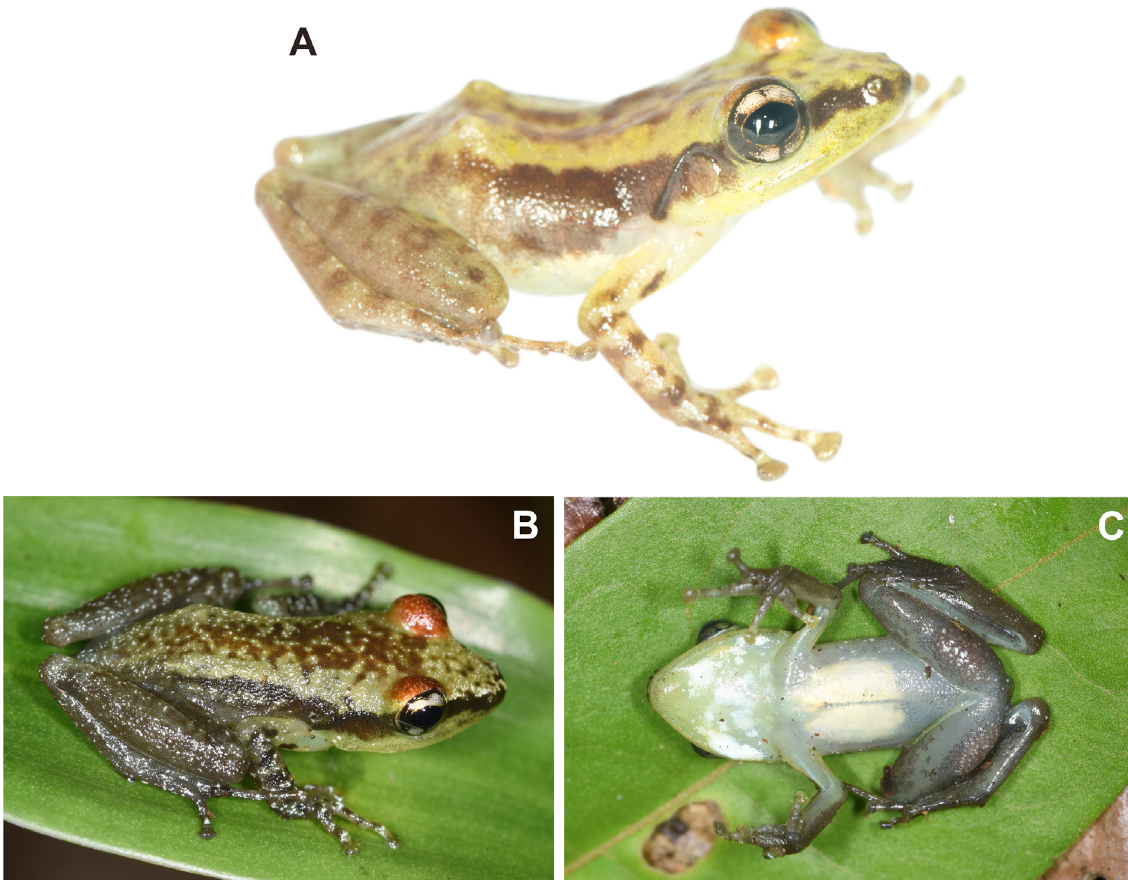
Fig. 5. Guibemantis woosteri sp. nov. in life. A . zSM 425/2016 (zCMV 15185) from Marojejy. B–C . zSM 426/2016 (zCMV 15198) from Marojejy in dorsolateral and ventral